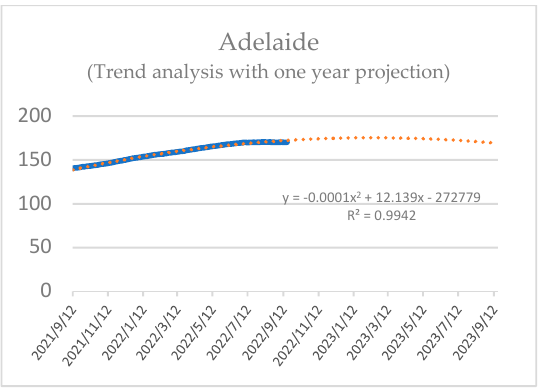
Figure 10. Trend analysis and one year prediction on housing prices for Adelaide.